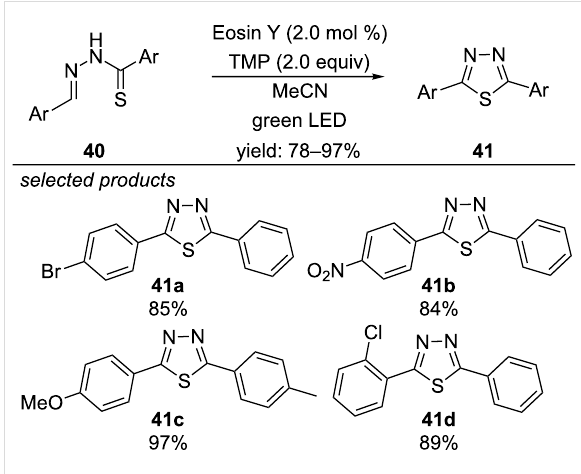
the respective N -aryl thioureas with Eosin Y as photoredox catalyst and molecular oxygen as terminal oxidant was shown (Scheme 33) [68]. They propose a mechanism where the excited state of Eosin Y is quenched reductively by the deprotonated thiourea derivative giving the Eosin Y radical anion and a thiyl radical. Aerobic oxidation closes the catalytic cycle and after hydrogen atom abstraction of the carbon-centred radical inter- mediate the final product is